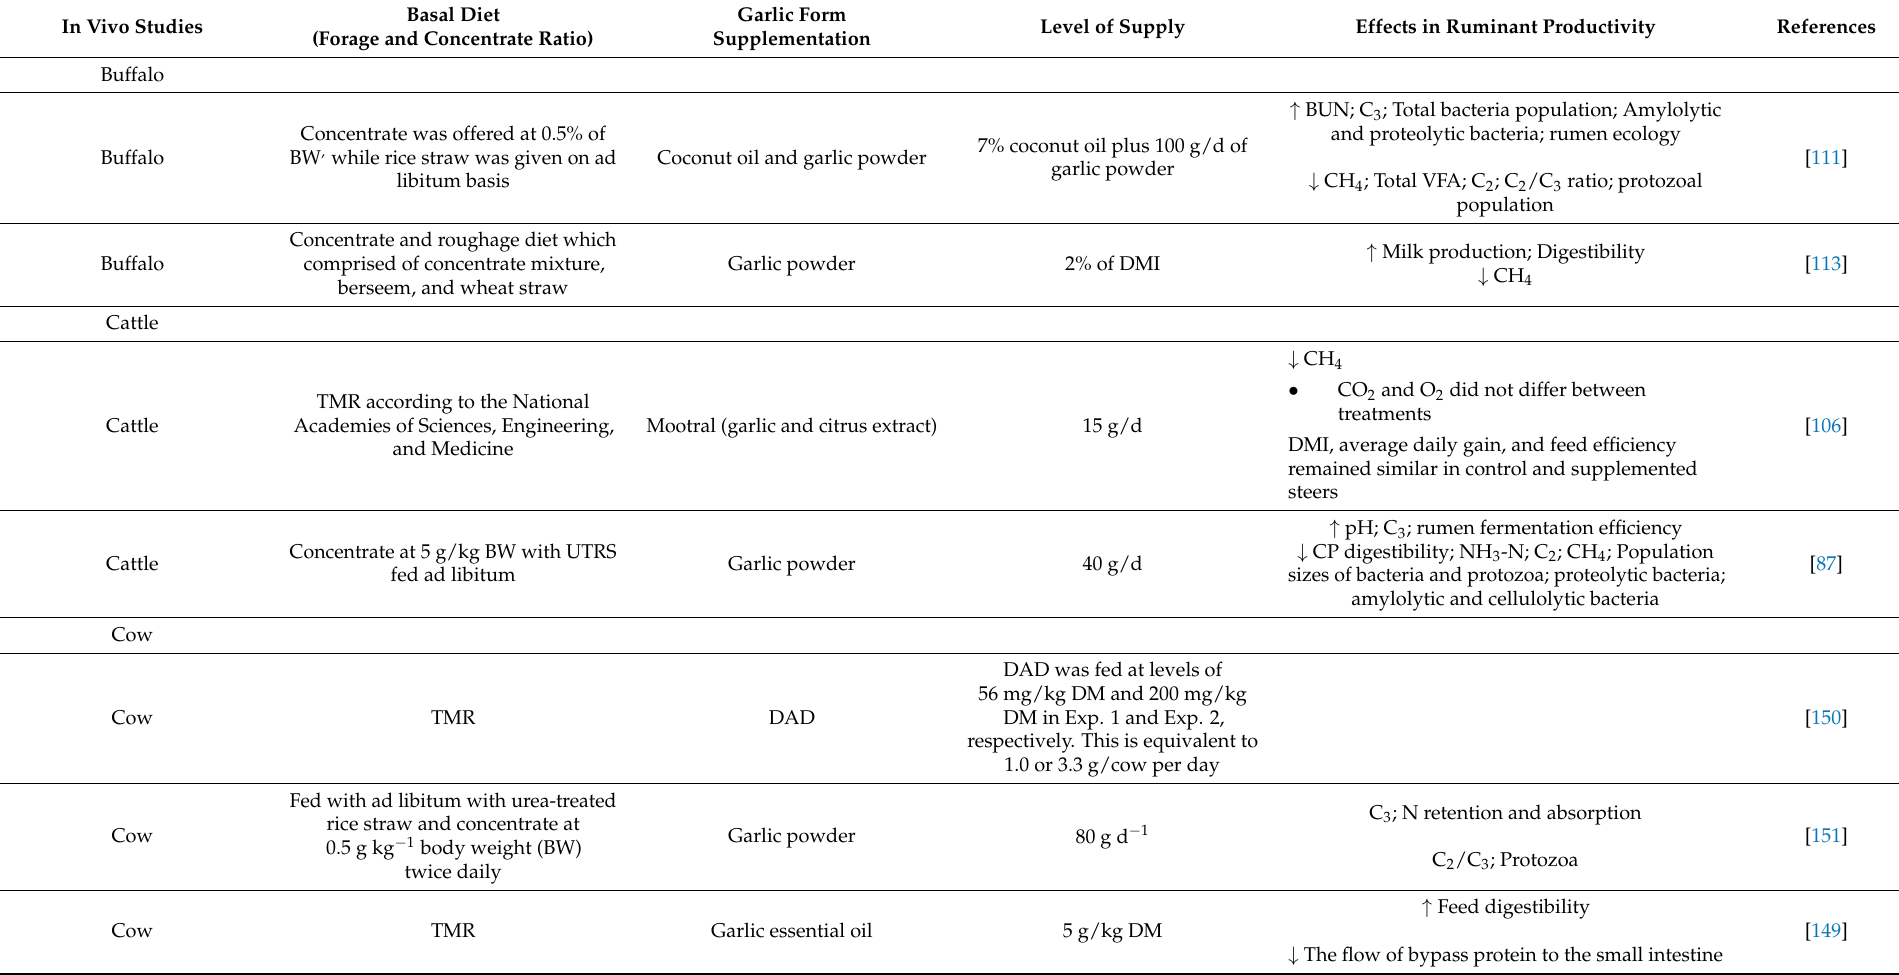
Table 5. In vivo trials that studied the effect of garlic on ruminant